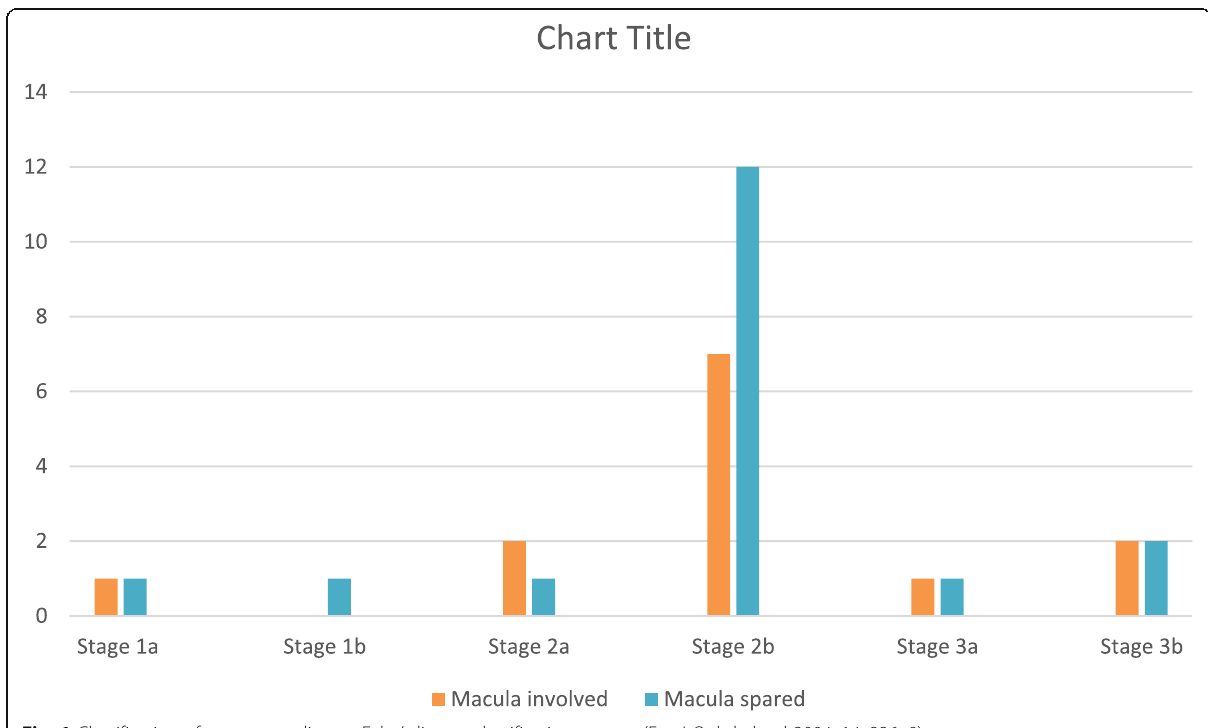
Fig. 1 Classification of cases according to Eales ’ disease classification system. (Eur J Ophthalmol 2004; 14: 236 – 9)